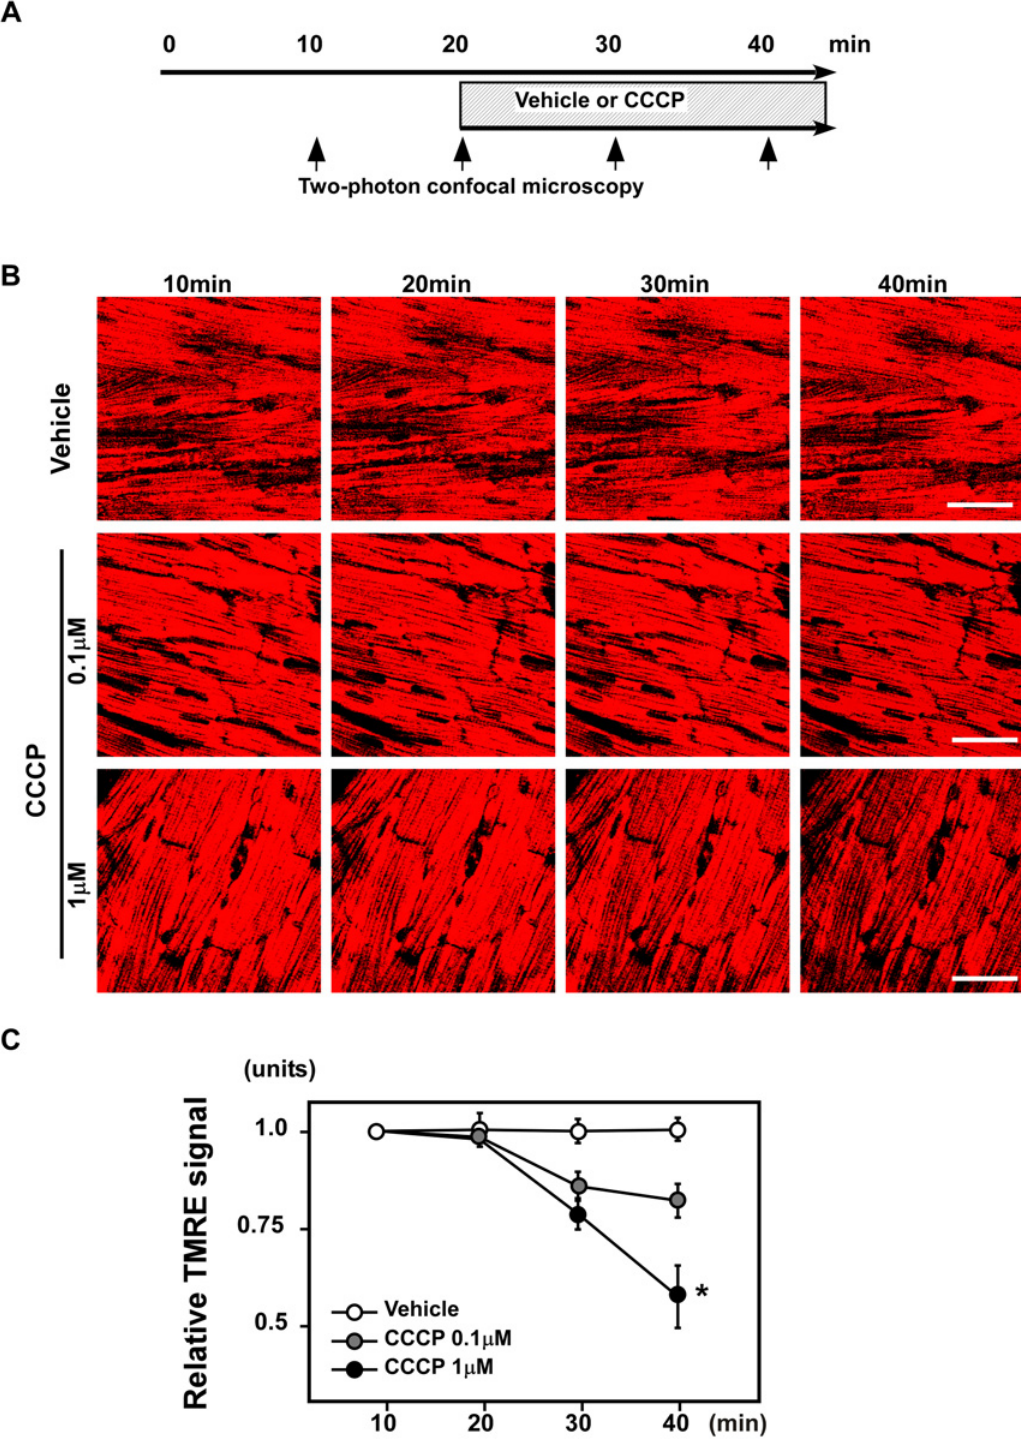
Figure 1. CCCP decreased TMRE signals in ex vivo perfused hearts. (A) Schematic of the experiment. Hearts were perfused with TMRE, and the signals were observed using two-photon laser microscopy. The images were obtained serially from hearts perfused with buffer containing vehicle or CCCP (0.1 or 1 μ M). (B) Representative images of TMRE signals. Scale bar: 50 μ m. (C) CCCP decreased the TMRE signals of perfused hearts in a dose-dependent manner 20 min after CCCP perfusion (n = 3 – 4 per group). * P < 0.05 versus